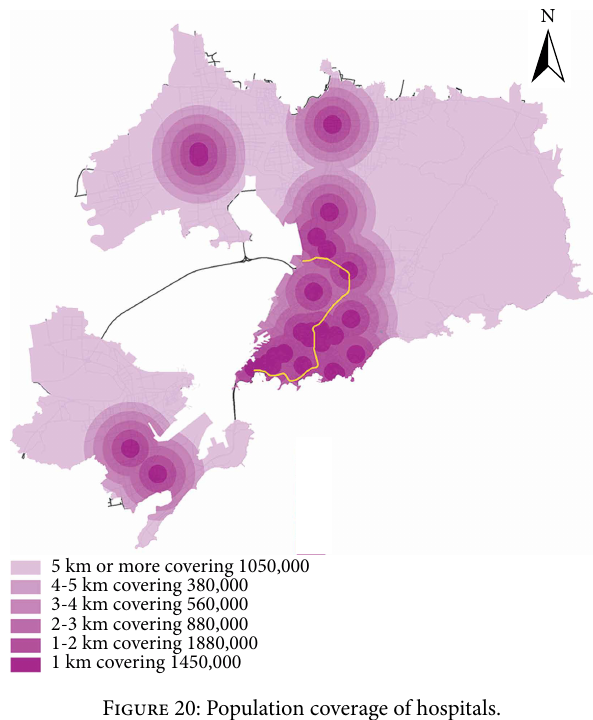
Figure 20: Population coverage of hospitals.